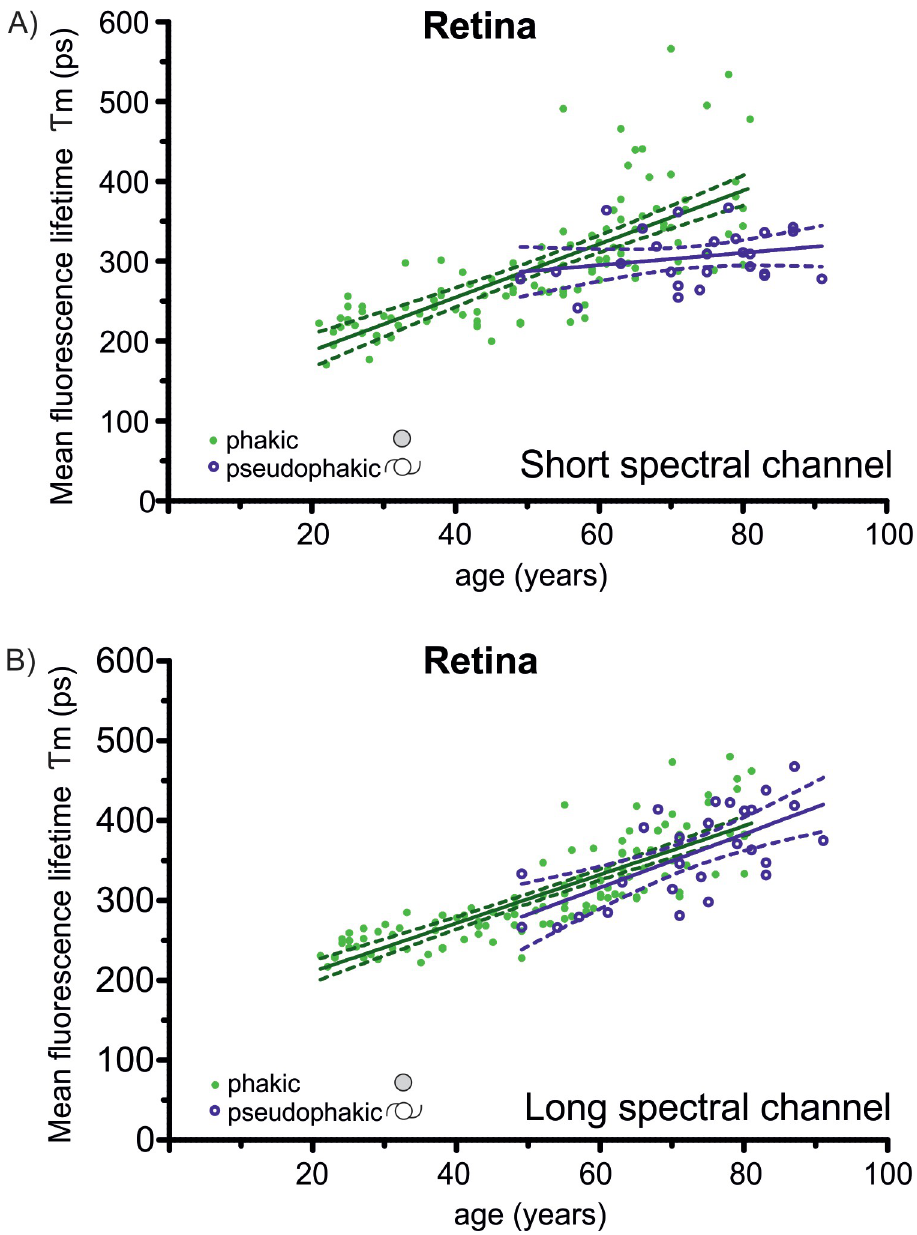
Fig 4. Correlation of mean fluorescence lifetimes with age. In phakic eyes, the mean fluorescence lifetime ( Tm , ETRDS inner ring) of the retina increased with age in both spectral channel (A+B) (SSC: r 2 = 0.54, LSC: r 2 = 0.7; p < 0.0001). In the short spectral channel (A), in phakic subjects aged around 60 years and above, a marked increase of FLT values and of the inter-individual variation were measured. In pseudophakic eyes, there was no prolongation in FLT in pseudophakic eyes in the short spectral channel (A, r 2 = 0.066; p = 0.2). In the long spectral channel (B), in pseudophakic subjects a prolongation of FLT with age was observed, which lays in the order of the increase in phakic subjects (r 2 = 0.44; p =